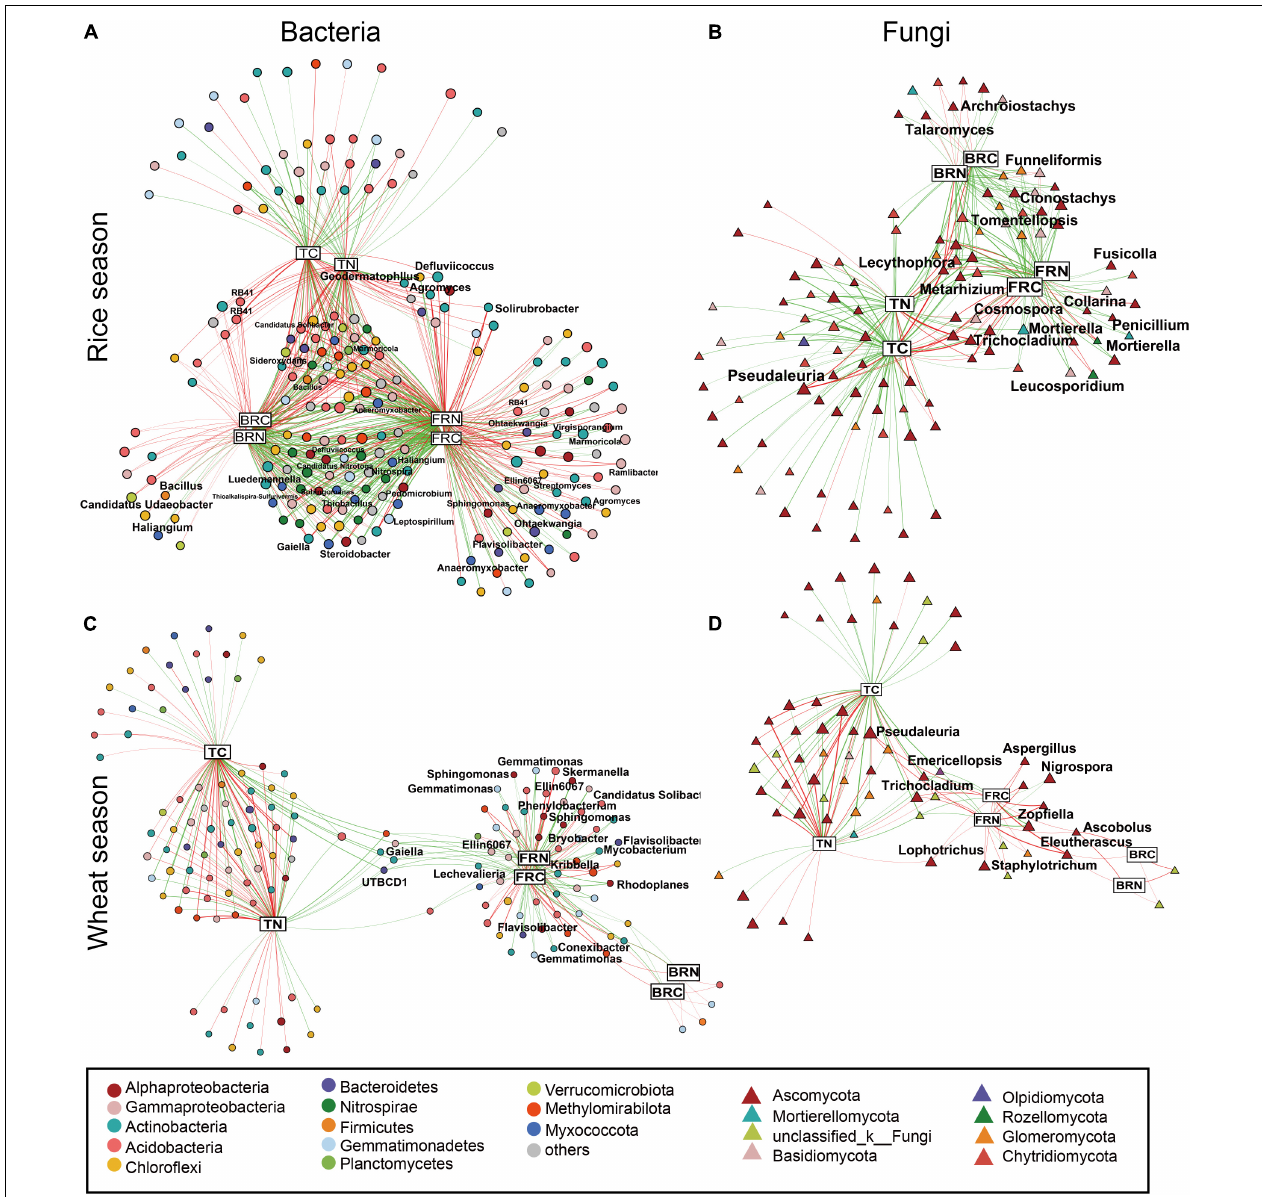
FIGURE 3 | Association networks of microbial OTUs and soil variables. Bacterial networks in rice (A) and wheat (C) season, and fungal networks in rice (B) and wheat (D) season. OTUs are represented by circles, and soil variables by rectangle. Nodes’ sizes reflect their degrees, and are colored based on their taxonomic information. Green and red edges indicate positive and negative correlations, respectively. Wider edges reflect stronger correlations. BPC1, sample values in PC1 axis of bacterial PCoA; BPC2, sample values in PC2 of bacterial PCoA; FPC1, values in PC1 of fungal PCoA; FPC2, values in PC2 of fungal PCoA; BRC, bacterial residues C; BRN, bacterial residues N; FRC, fungal residues C; FRN, fungal residues N. Abbreviations: see Figure 2